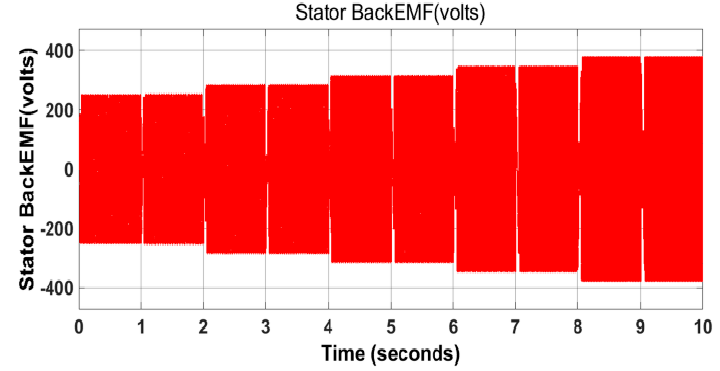
Figure 13. Stator back-EMF of BLDC motor for ten seconds.